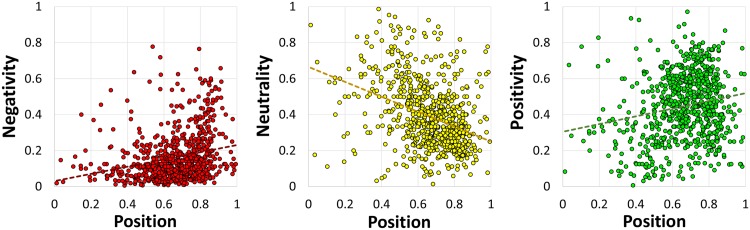
Negativity, neutrality, and positivity regressed with position (from left to right).The trendlines are functions p
c(d) of the distance d from the beginning of the tweets.